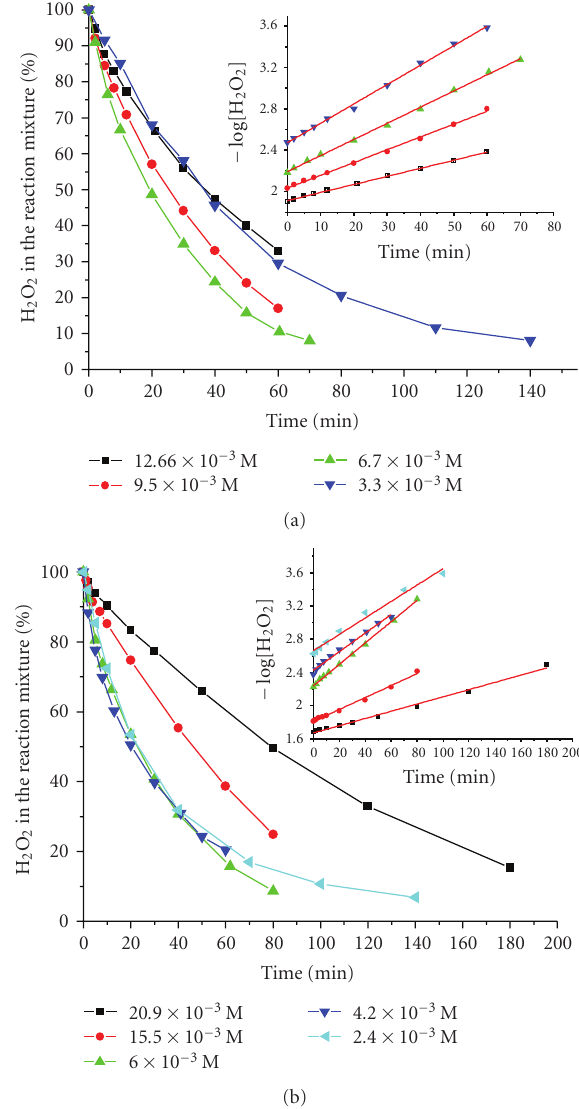
Figure 1: The variation of [H 2 O 2 ] in the reaction mixture (% of the initial concentration) and (insert) negative logarithm of titrated H 2 O 2 concentration versus time, from solutions of di ff erent initial [H 2 O 2 ] at pH = 8 . 7 for the system (a) PAla-Cu(II), [PAla] = 2.0 × 10 − 3 M, [Cu 2+ ] = 5.0 × 10 − 4 M. T = 298 K. (b) PGlygly-Cu(II), [PGlygly] = 2.0 × 10 − 3 M, [Cu 2+ ] = 5.0 × 10 − 4 M. T = 298 K.